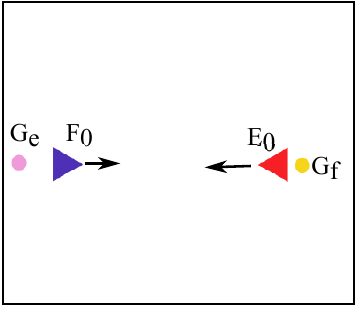
Figure 1. The enemy avoidance